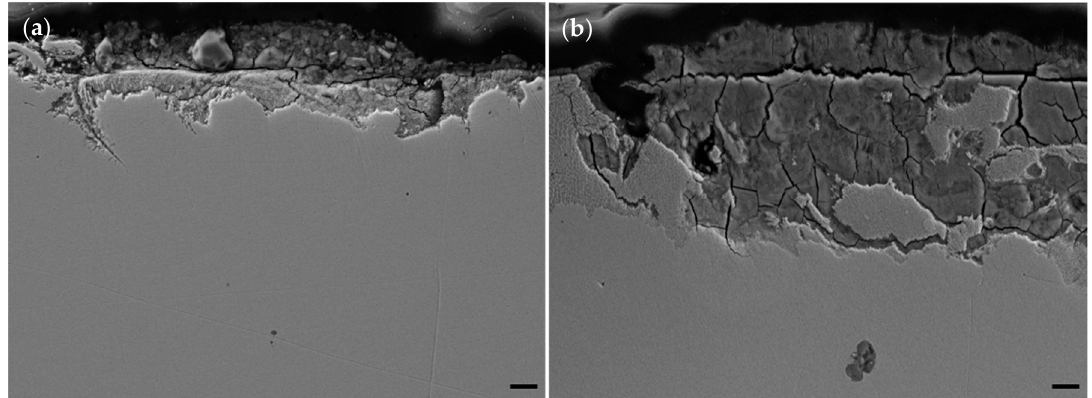
Figure 9. SEM images of ( a ) 3VAP and ( b ) 3V600 showing differences in corrosion susceptibility. The scale for both images is 10 μ m.